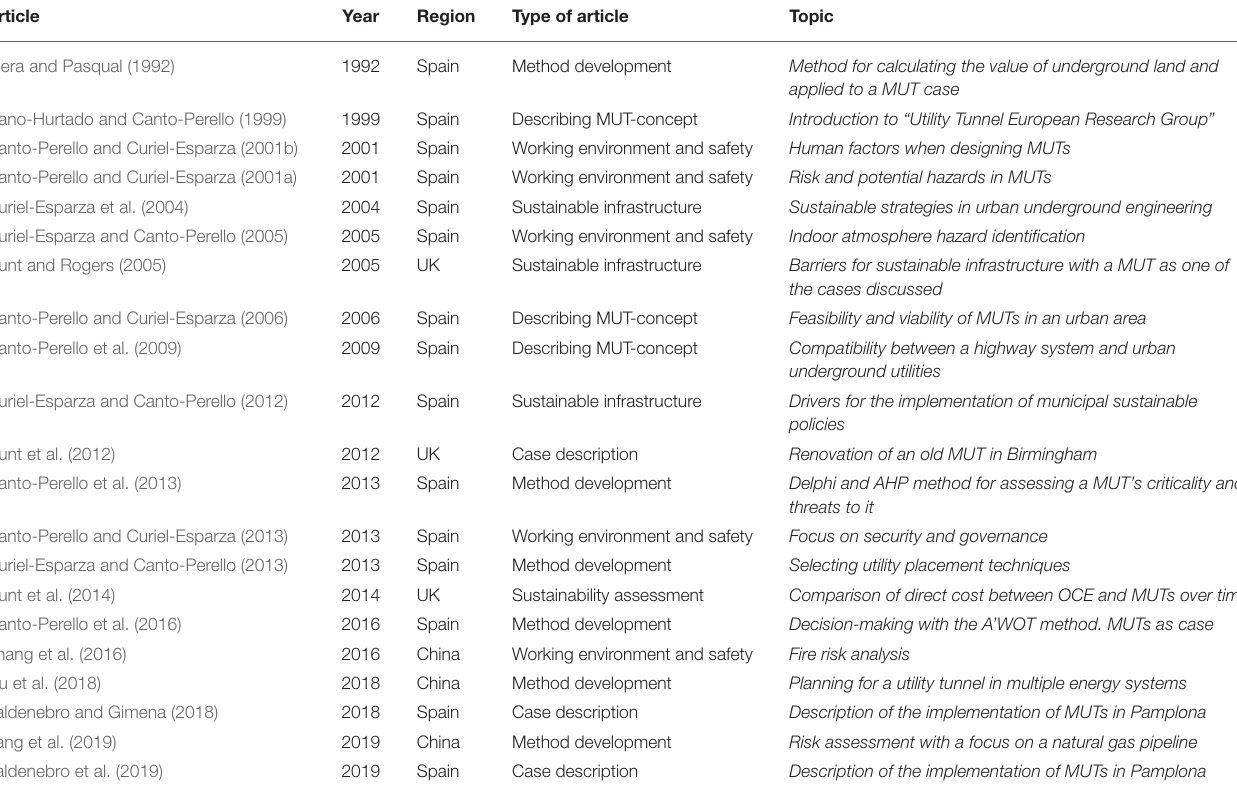
TABLE 1 | Overview of the selected literature for this review with a presentation of the year of publication, the origin of the university for the main author, type of article and